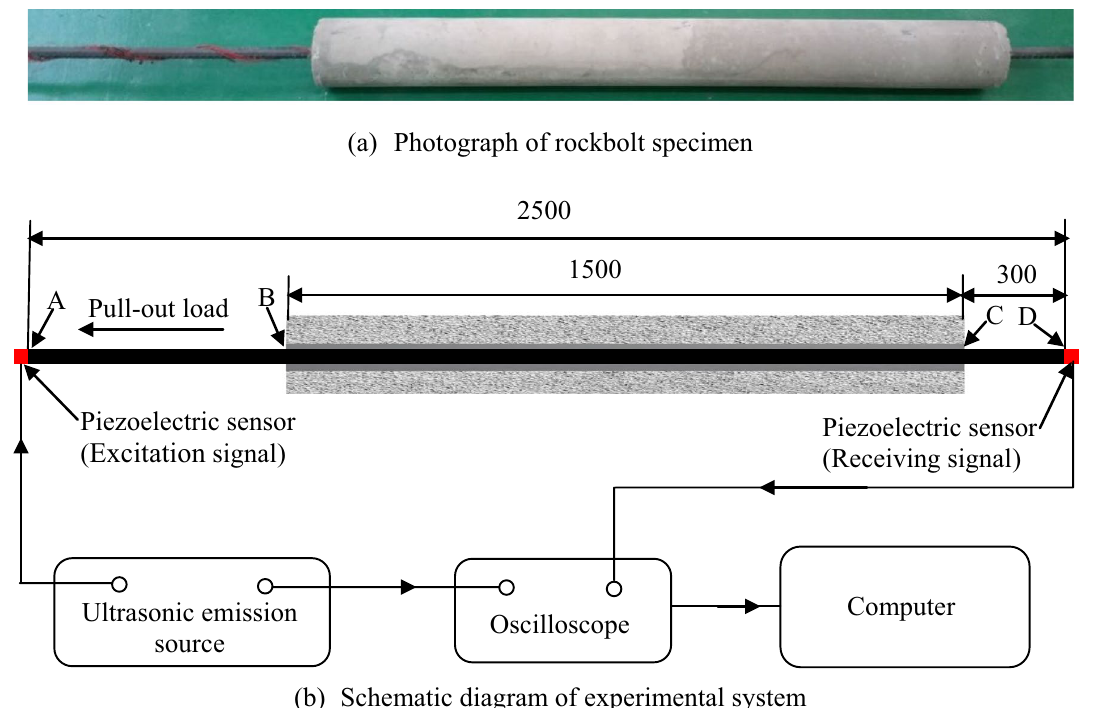
Fig. 2 The schematic diagram for detection of guided wave propagation in grouted rockbolt system (unit: